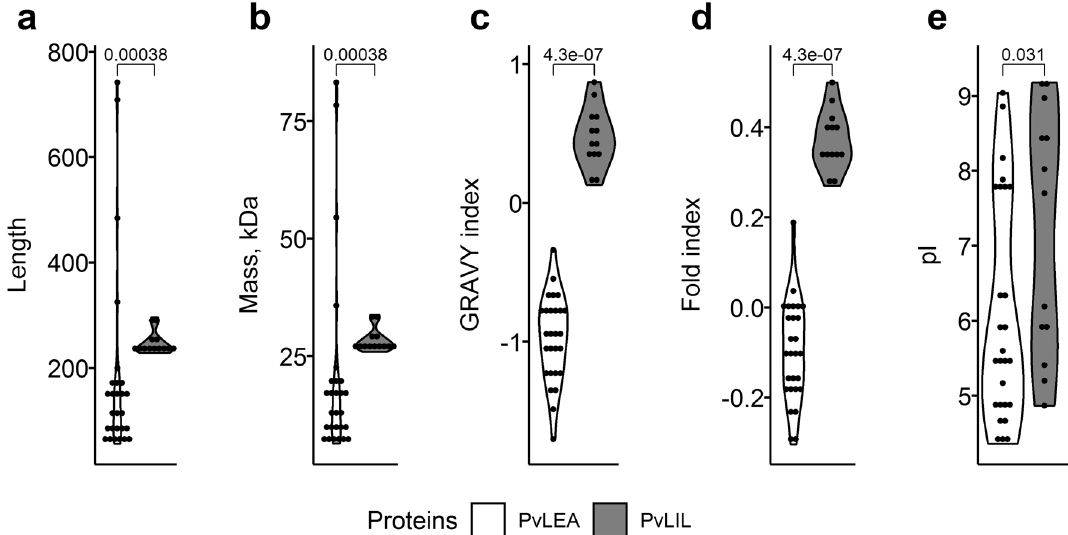
Figure 3. Properties of PvLIL proteins in comparison to PvLEA proteins. ( a ) Length of PvLIL and PvLEA proteins. ( b ) Predicted molecular mass of PvLIL and PvLEA proteins. ( c ) GRAVY index corresponding to the average protein hydrophobicity in PvLIL and PvLEA proteins. Increased GRAVY index values reflect increased hydrophobicity of PvLIL in comparison to PvLEA proteins. ( d ) Diagram of fold index in PvLIL and PvLEA proteins, reflecting whether protein is intrinsically disordered or not (negative and positive values, respectively). In contrast to typical PvLEA proteins, PvLIL proteins are not intrinsically disordered. The positive fold index of some PvLEA reflects the presence of folded domains in these proteins. ( e ) Predicted values of isoelectric point for PvLIL and PvLEA proteins. Molecular mass, GRAVY index and isoelectric point were predicted with ProtParam service 18 , fold index was predicted with FoldIndex 52 . Values of corresponding characteristics are plotted along y-axis. p values on the top of each plot were obtained in two-sided Wilcoxon test; n = 13 and 27 for PvLIL and PvLEA, respectively. Continuity correction was introduced to compensate for the presence of tied values; alternative p values obtained in 1,000 test replicates with the introduction of random noise were lower than those obtained using correction (see Methods). Data for PvLEA proteins were taken from 19 and reproduced using the same bioinformatic tools. Black circles depict values of corresponding characteristics for individual